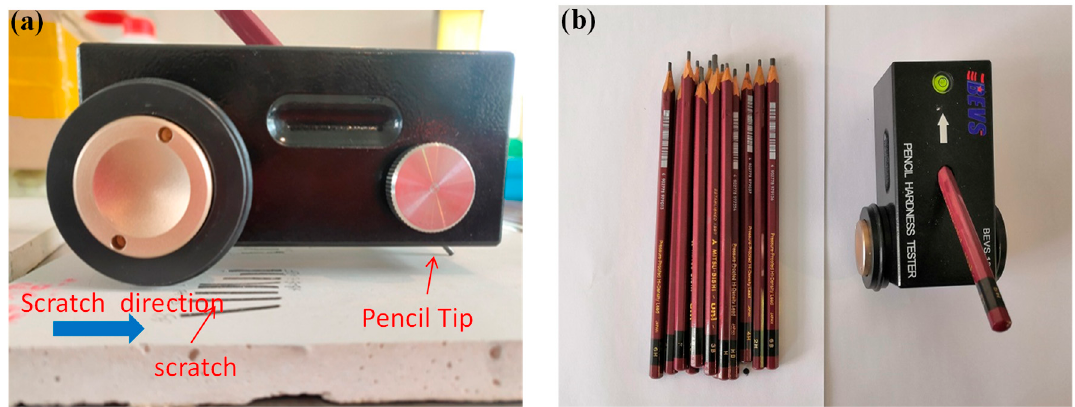
Figure 2. Pencil hardness tester. ( a ) Pencil hardness tester. ( b ) Pencil.